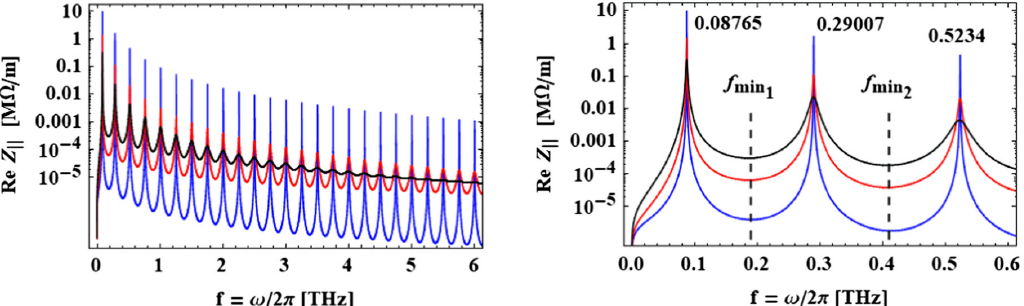
FIG. 2. The real part of longitudinal monopole impedance of a two-layer metal-dielectric waveguide for ε 0 1 ¼ 10 and for three different values of ε 00 1 : ε 00 1 ¼ 0 (blue line), 0.1 (red line), and 0.5 (black line). Left: Wide terahertz range of impedance distribution. Right: The resonant frequencies of the first three extremes of the same resonance curve are shown; f part of impedance, separating the contributions of individual modes.